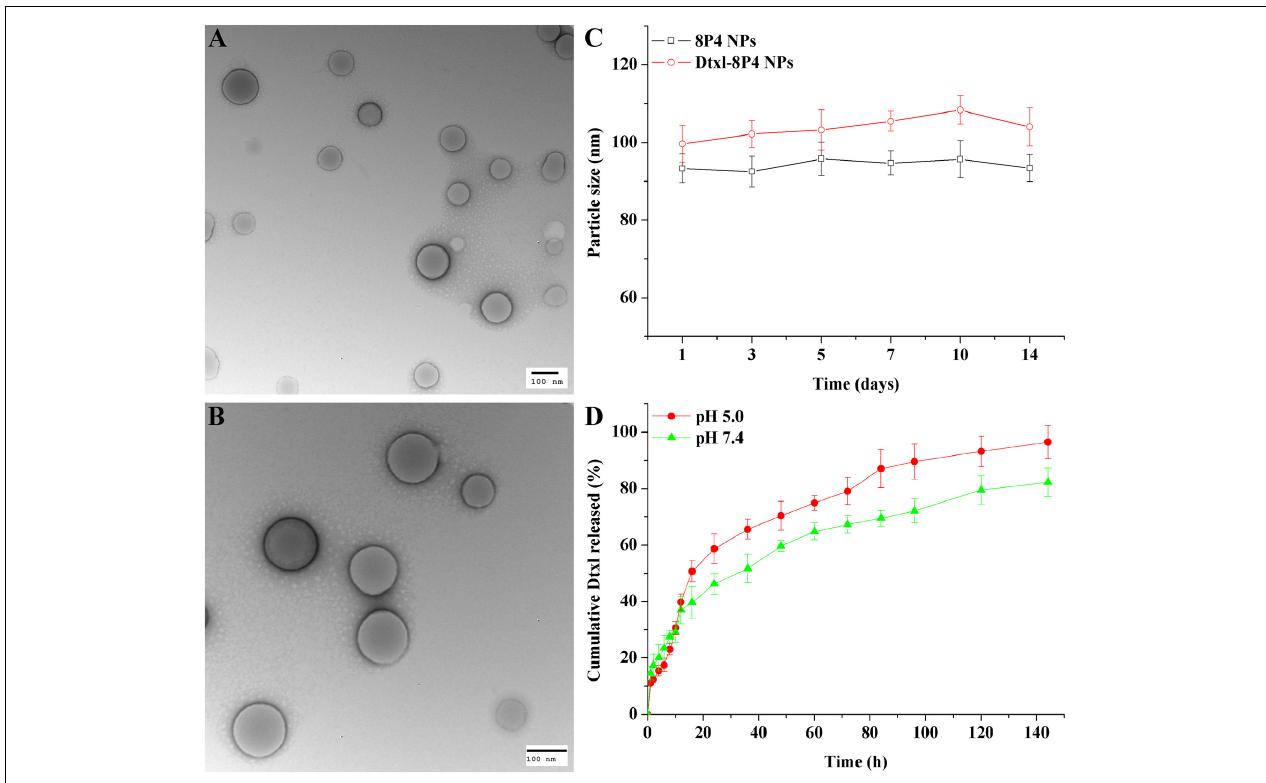
FIGURE 3 | TEM images of (A) 8P4 NPs and (B) Dtxl-8P4 NPs. (C) Particle size of 8P4 NPs and Dtxl-8P4 NPs. (D) The cumulative release profiles of Dtxl-8P4